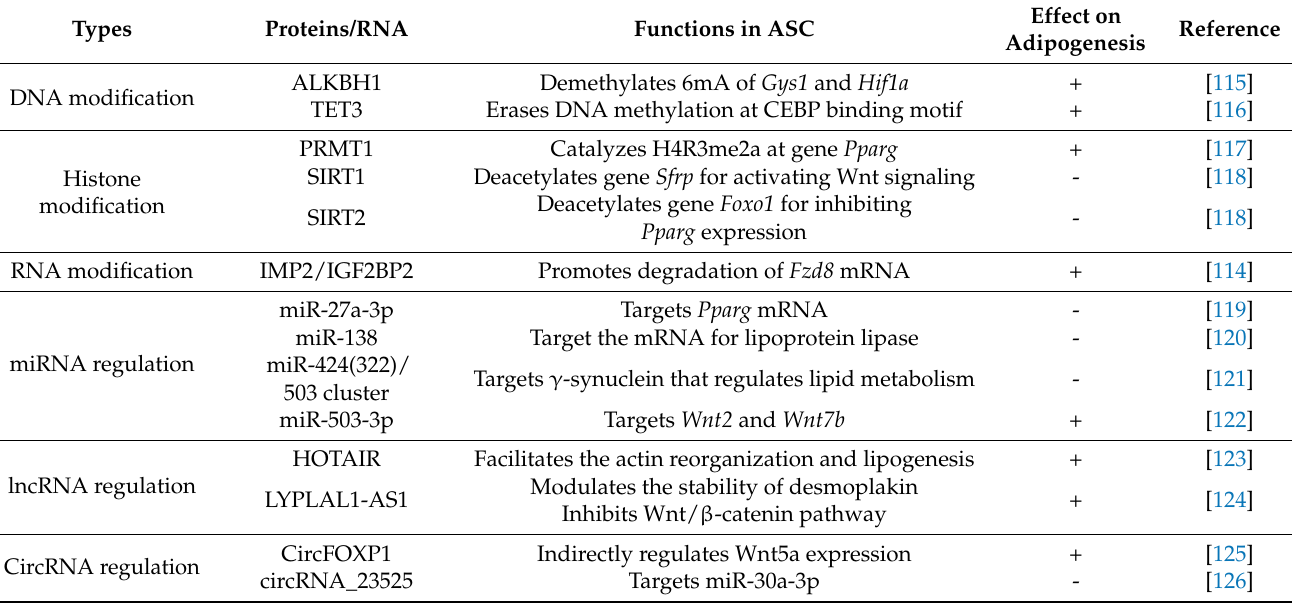
Table 2. Recent discoveries in epigenetic modification of adipogenesis in